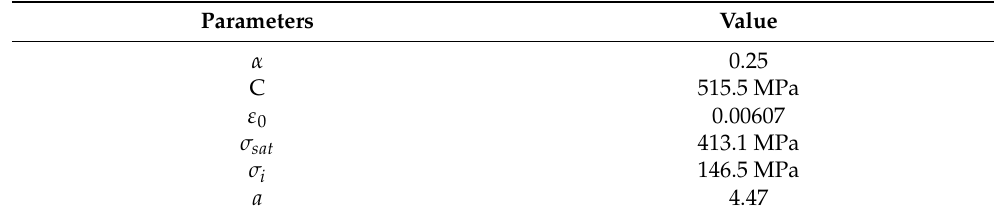
Table 1. Parameters of Swift and Hockett–Sherby model.